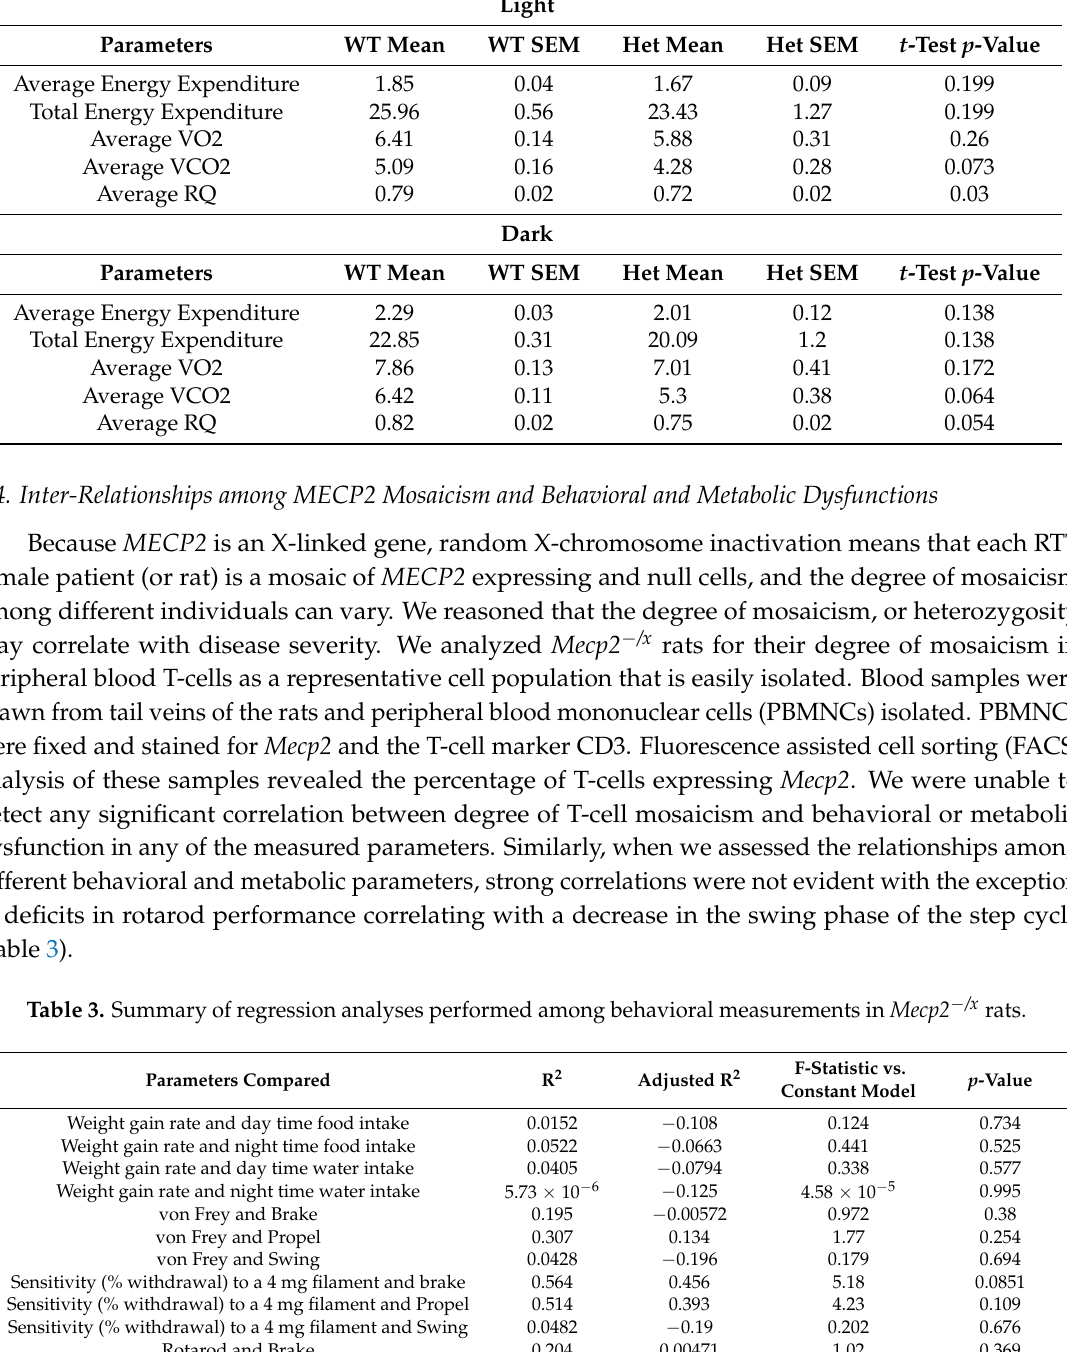
Table 2. Metabolic indices measured by calorimetry during light and dark phases over a 48-h test period in wild type (WT) and heterozygous (Het) rats. VO2 = oxygen consumed as O2 mL/min. VCO2 = carbon dioxide produced as mL/min. RQ = Respiratory Quotient obtained as VCO2/VO2. All measurements are from a single rat per cage. Light WT Mean Het SEM